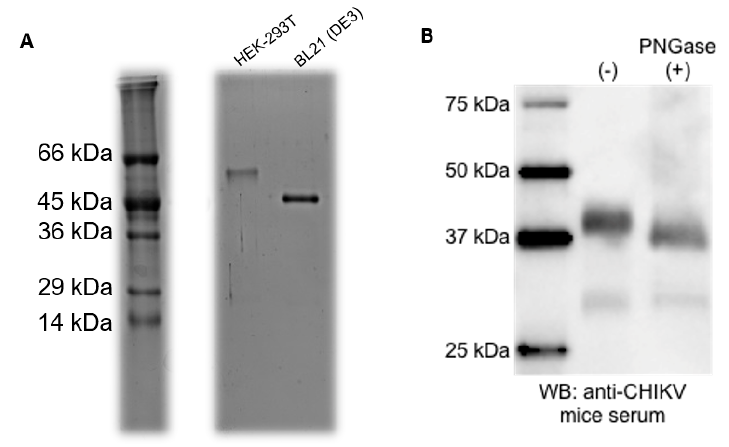
Figure 2. Comparison of molecular mass and glycosylation analysis in CHIKV-E2 from HEK-293T. ( A ): Supernatant from HEK-293T cells and pellets from BL21 (DE3) cells were purified by affinity chromatography and evaluated in SDS-PAGE. ( B ): CHIKV-E2 produced in HEK-293T cells was treated with a PNGase F to remove all N-linked glycans and analyzed on western blot using anti-CHIKV mouse serum, showing that the higher molecular mass from the eukaryotic antigen is a result of protein glycosylation.